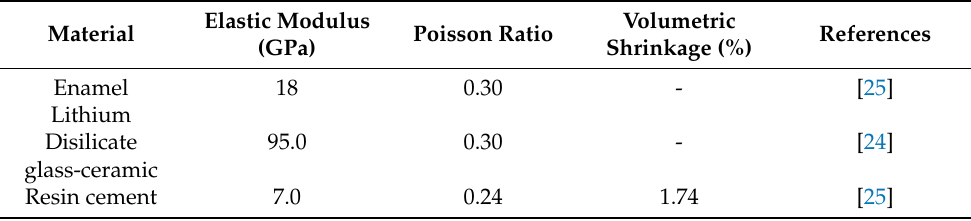
Table 1. Material properties considered to calculate the residual stress.